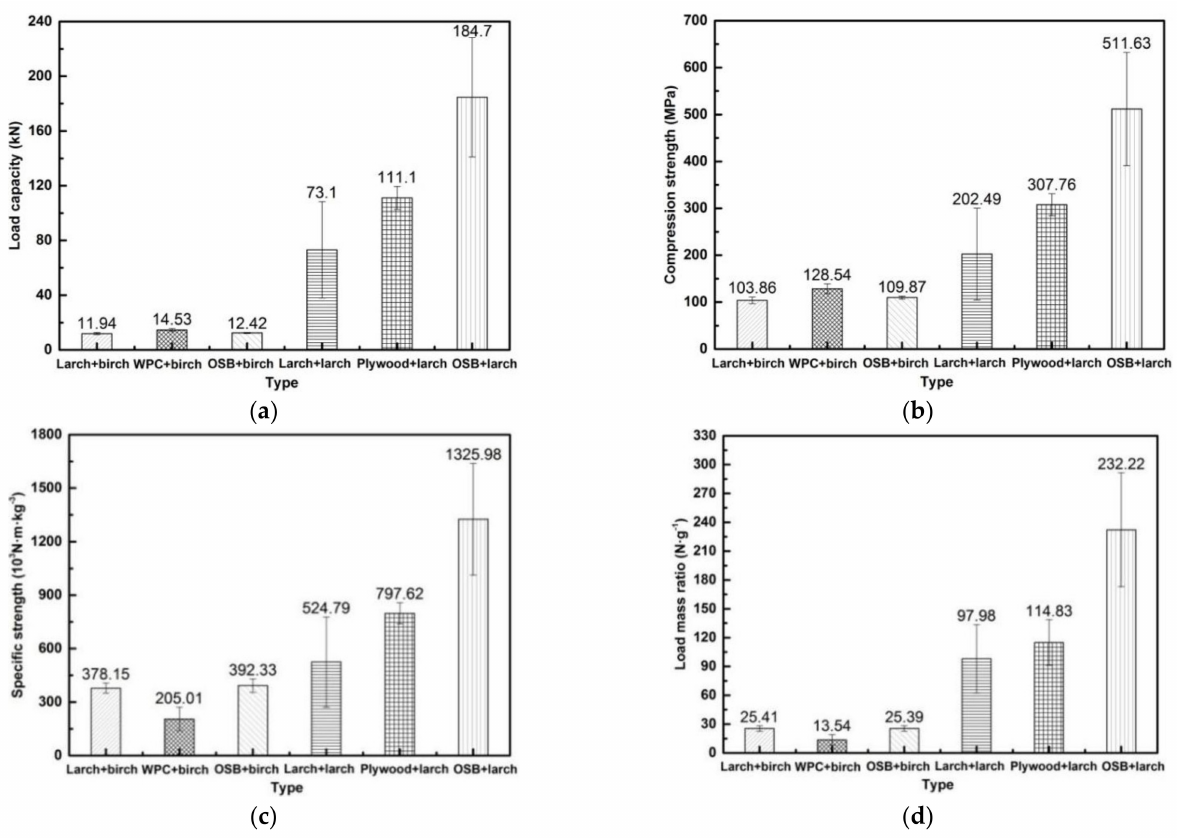
Figure 10. Performance comparison of wood-based pyramid structure and wood-based inter- locking grid structure. ( a ) Bearing capacity; ( b ) compressive strength; ( c ) specific strength; ( d ) mass–load ratio.